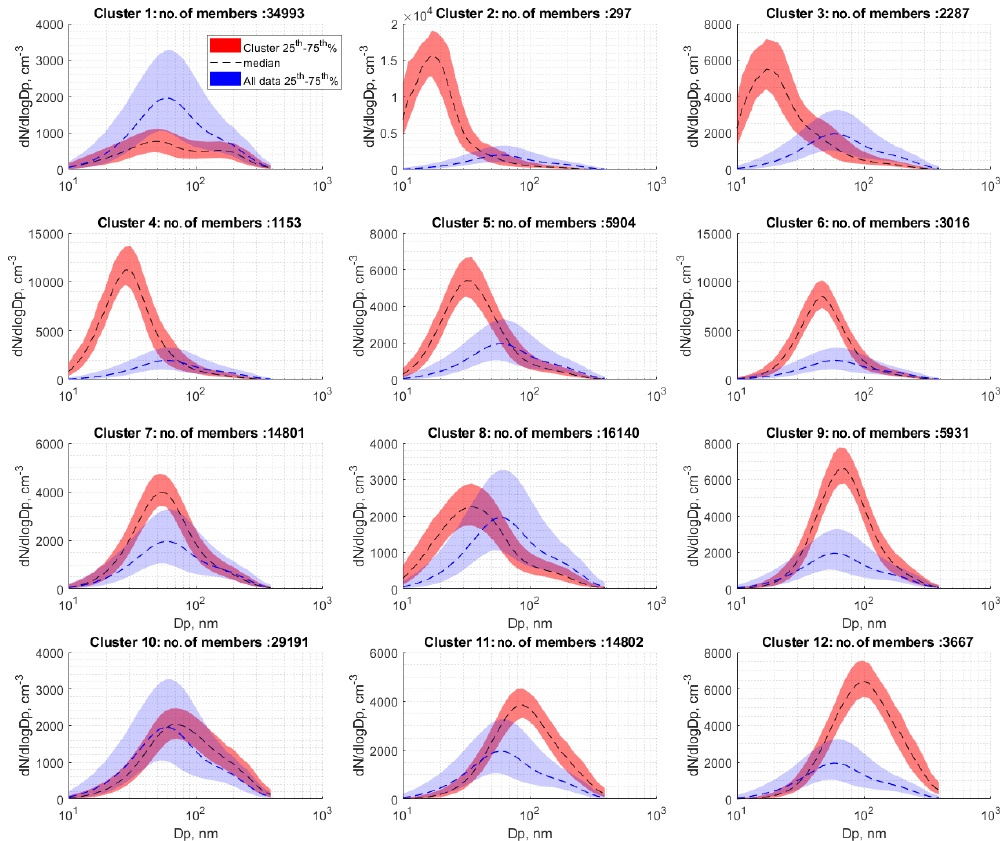
Figure 3. Aerosol number size distribution clusters for the 2000–2017 data record from Aspvreten, 58.8 ◦ N, 17.4 ◦ E. (a) Total of 132182 hourly size distributions included in the clustering. Number of cluster members is indicated in each frame. Clusters are ordered from left to right and up to down. The red shaded area indicates the 25th–75th percentile range of the cluster members and (b) the dashed lines indicate median number size distribution of that cluster. Indicated in blue shading is the 25th–75th percentile. GSD represents the geometric standard deviation and D g the geometric mean diameter of each of the log-normal